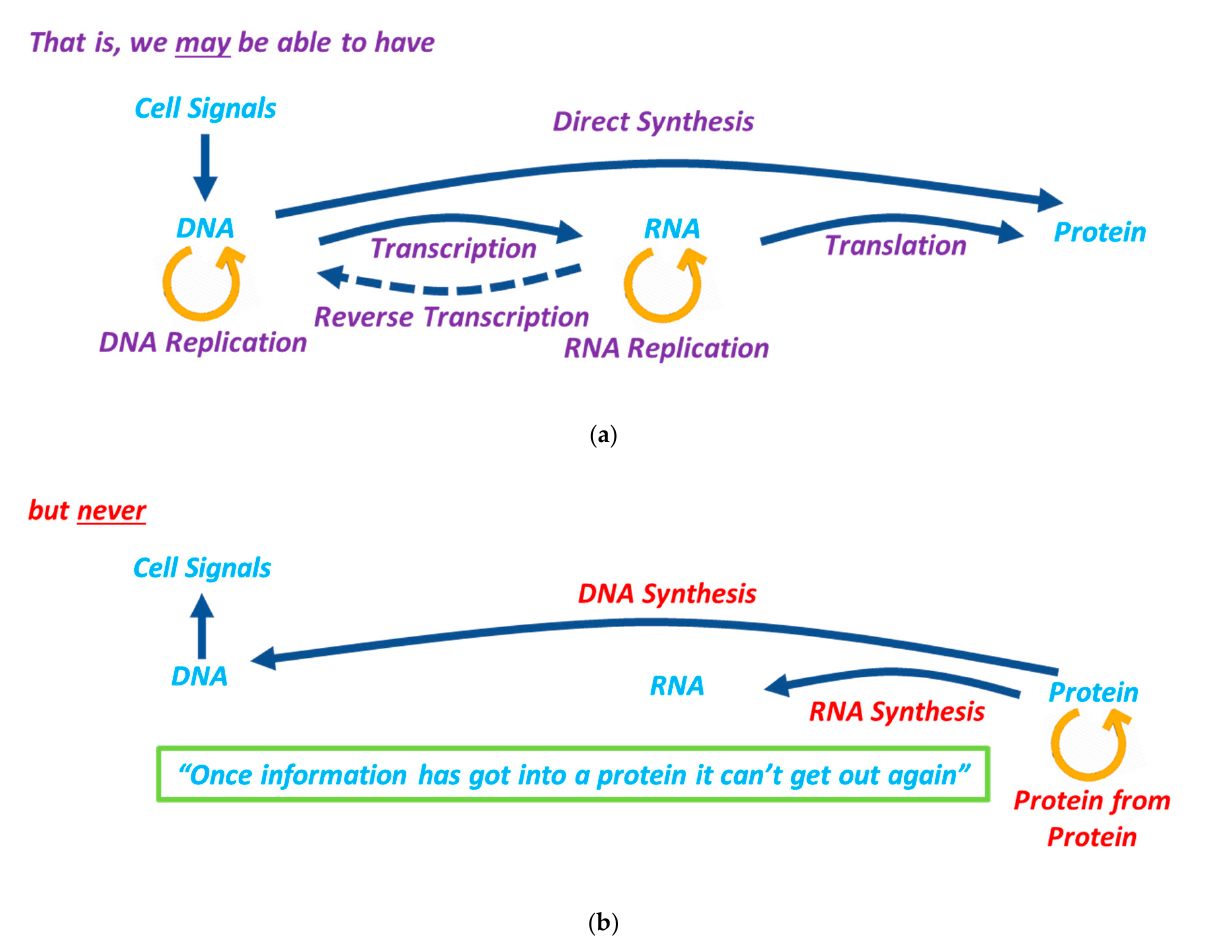
Figure 6. The central dogma of molecular biology: ( a ) The possible in genomic flow of information; ( b ) The impossible in genomic flow of information.